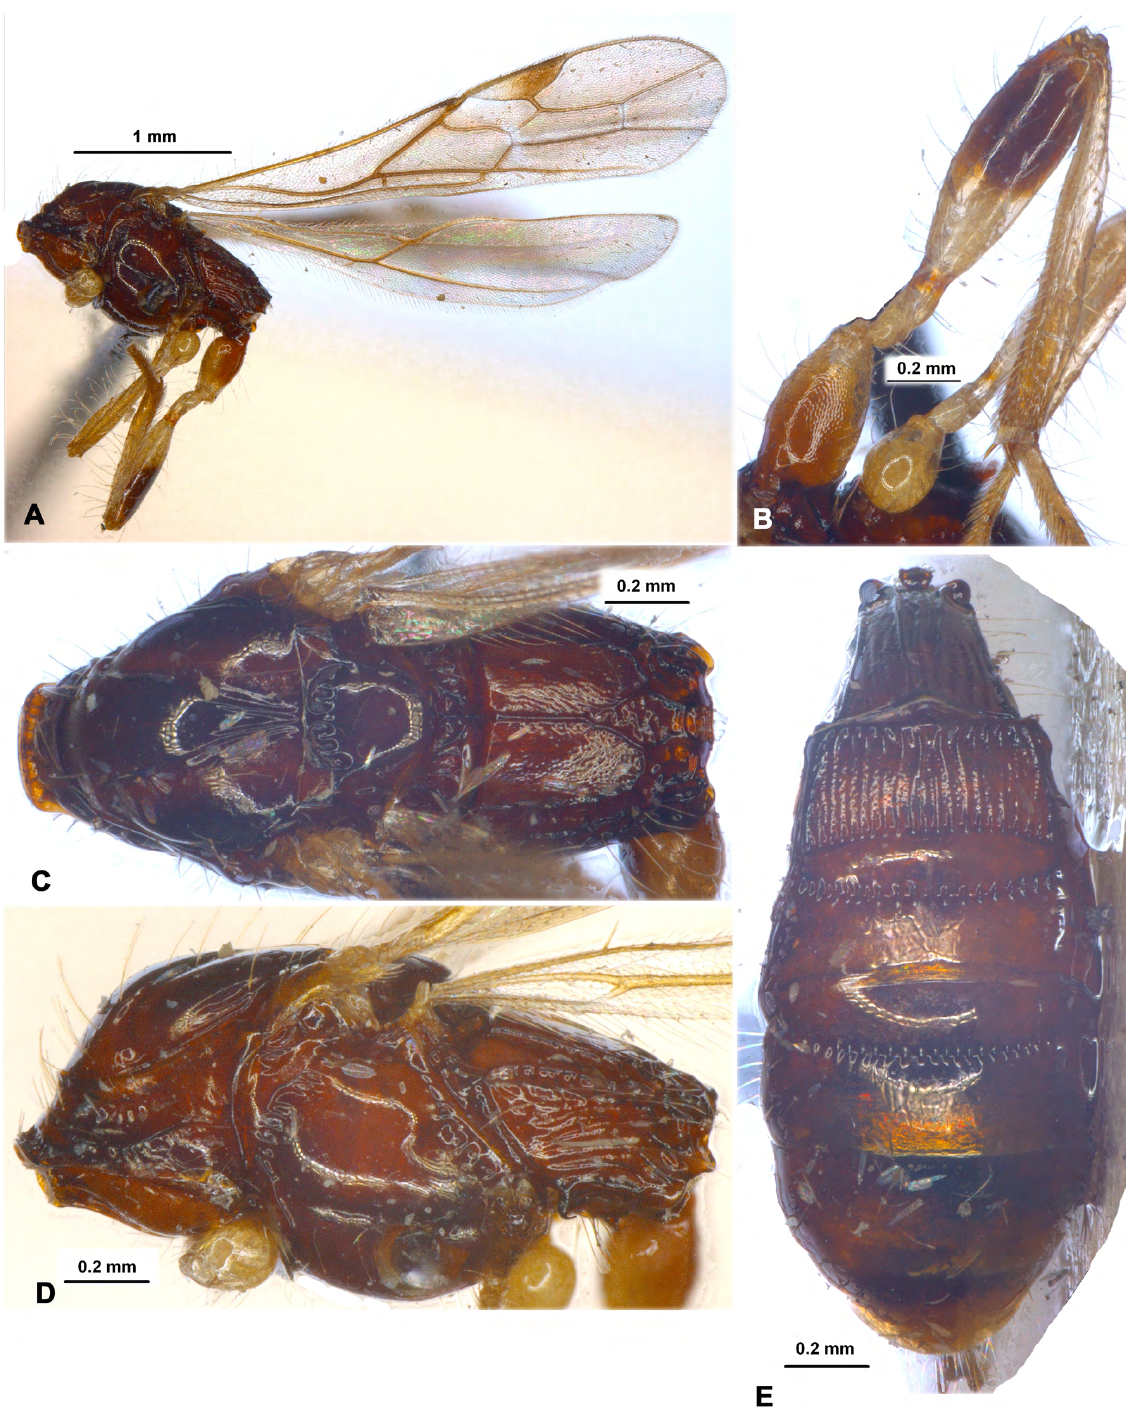
Fig. 16. Ipodoryctes ( Afroipodoryctes ) insignis (Granger, 1949), ♀, holotype, MNHM. A . Habitus, lateral view. B . Hind leg, lateral view. C . Mesosoma, dorsal view. D . Mesosoma, lateral view. E . Metasoma, dorsal